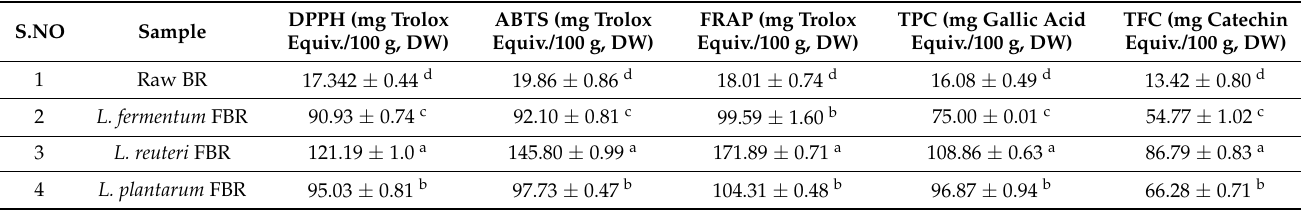
Table 1. Total antioxidants DPPH, ABTS, FRAP, total phenolic content (TPC), and total flavonoid content (TFC) of raw and different LABs fermented BR